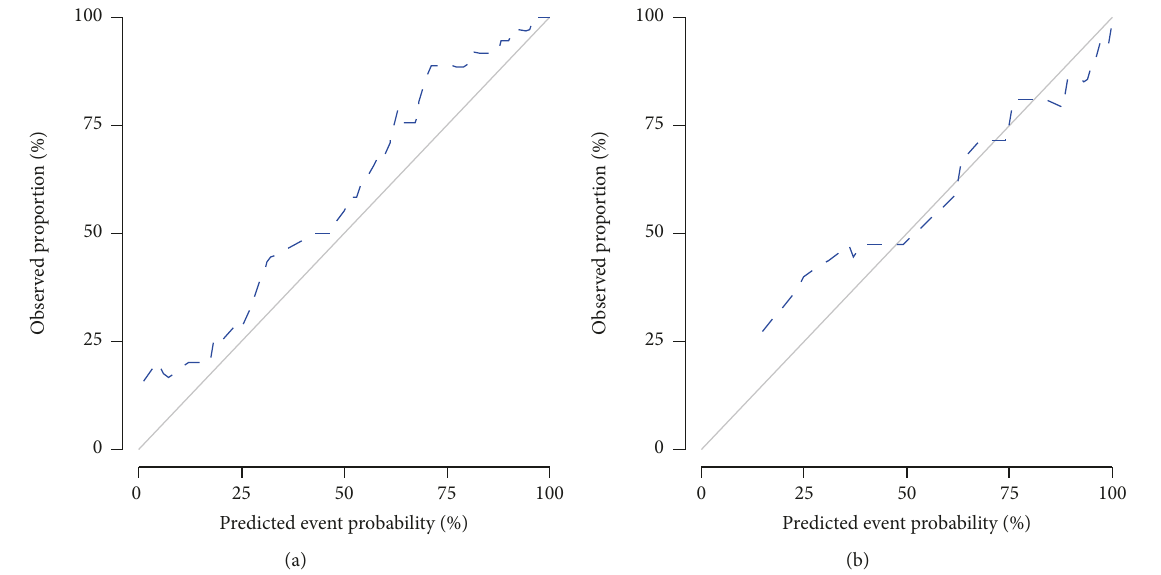
Figure 5: Calibration curve ((a) training group and (b) test group). Calibration curves exhibited excellent good of fit. Table 1: Results of radiomics, clinical, and combinational models. Accuracy